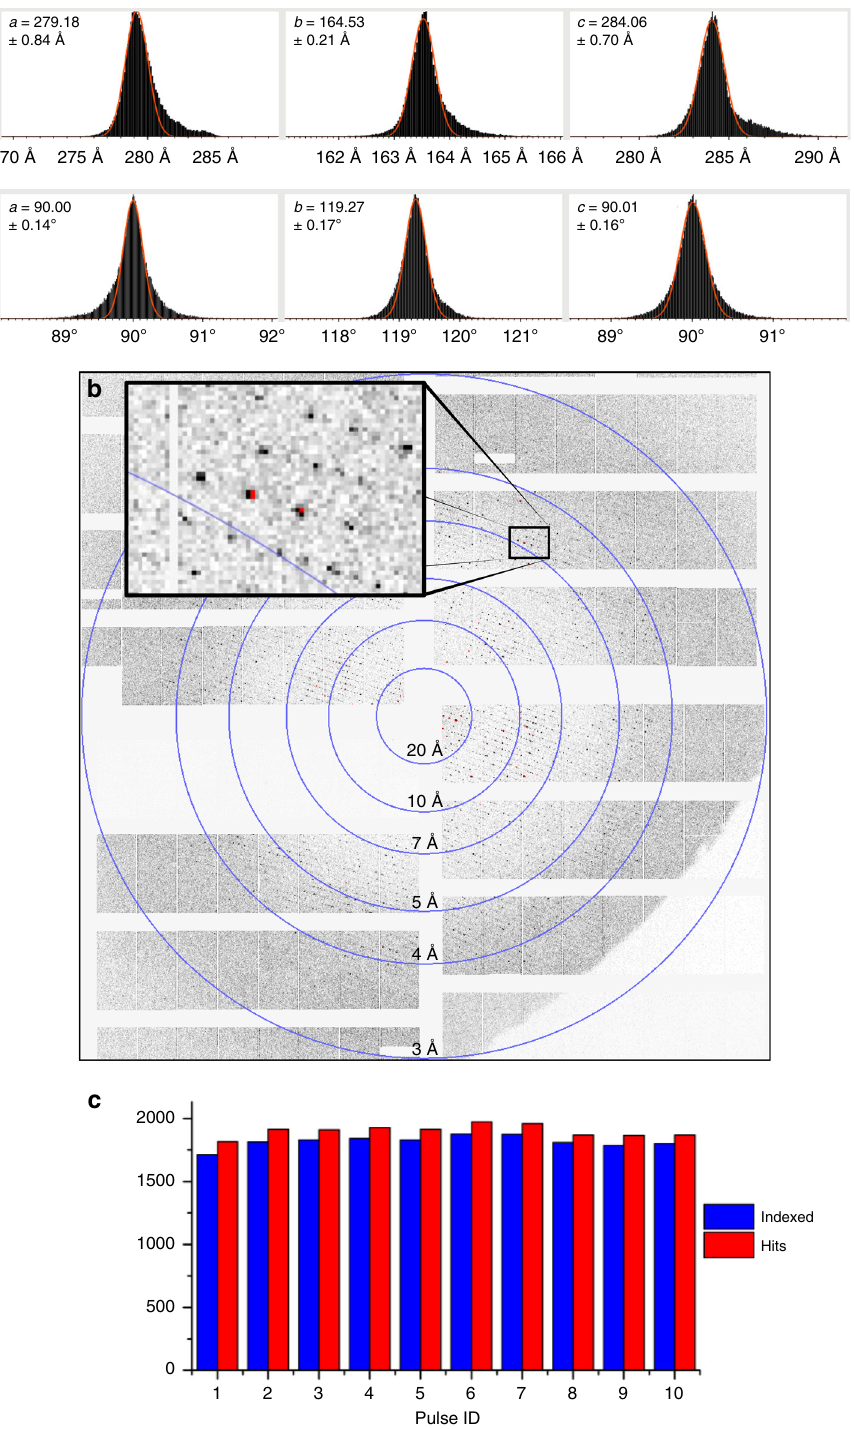
Fig. 2 Unit cell distribution, diffraction pattern, and indexing rates from PSI MHz SFX. a Unit cell distributions of PSI microcrystals showing narrowly distributed monoclinic unit cells. The red line shows a Gaussian function fi t to the unit cell constant distribution, and the corresponding peak value is listed in each subpanel. b Representative X-ray diffraction pattern with pixels in high-gain mode shown in black, and medium- or low-gain mode shown in red. Resolution rings are shown and labeled accordingly. c The number of hits (red) and indexed patterns (blue, ~93% of hits) for each